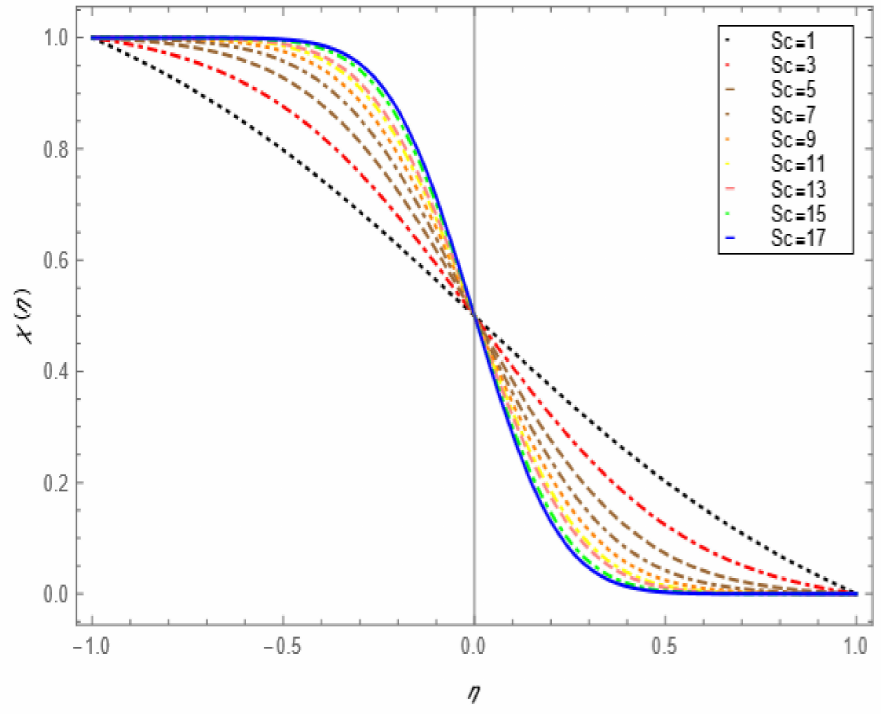
Figure 6. Concentration profile effect for Schmidt number for = − 1, Re = − 1, ϕ 1 = ϕ 2 = 0.03, Ec = 0.00068, Pr = 6.2, M =